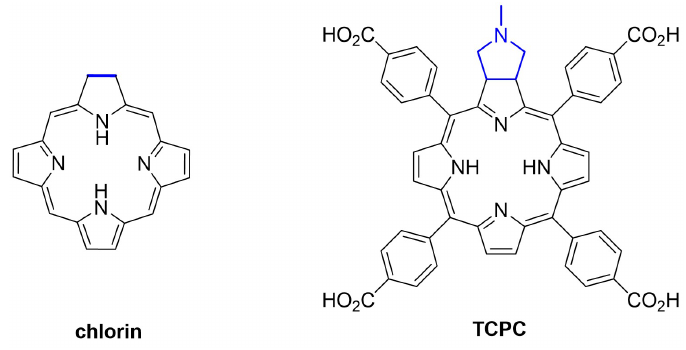
Figure 1. Structure of core chlorin and TCPC.